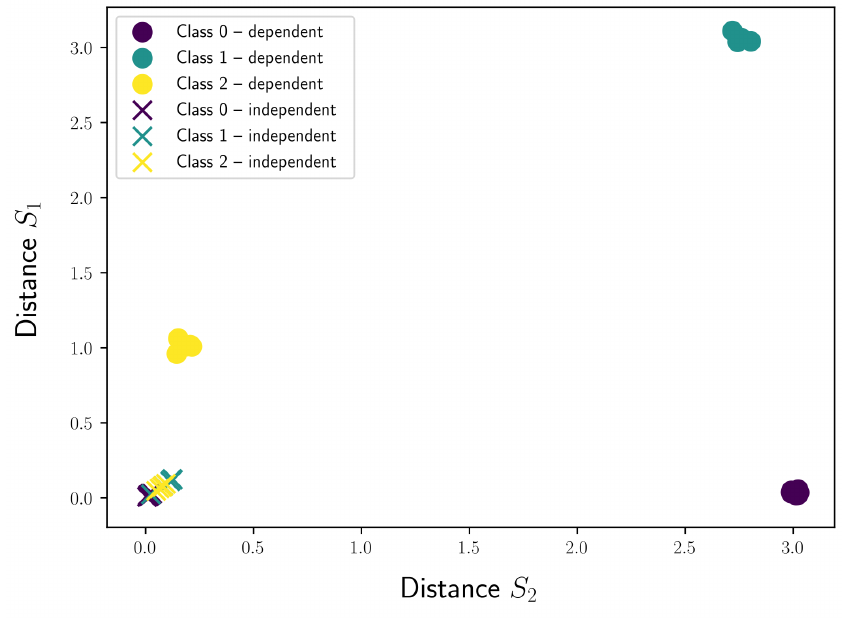
Figure 10. The obtained feature representations using a dependent and independent